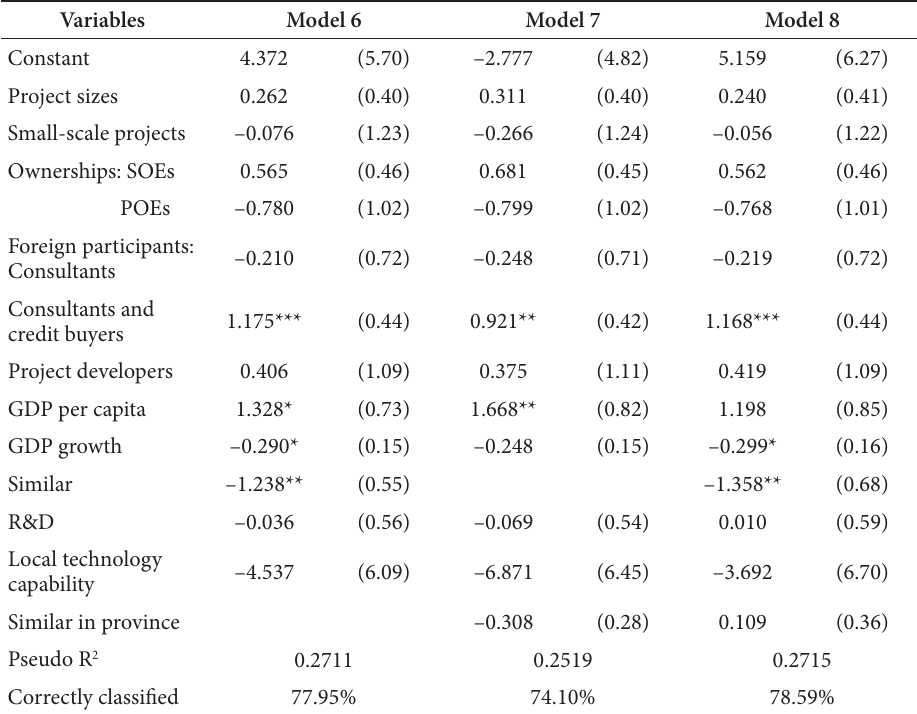
Table 9. Results of logistic regression analyses, with Wind projects